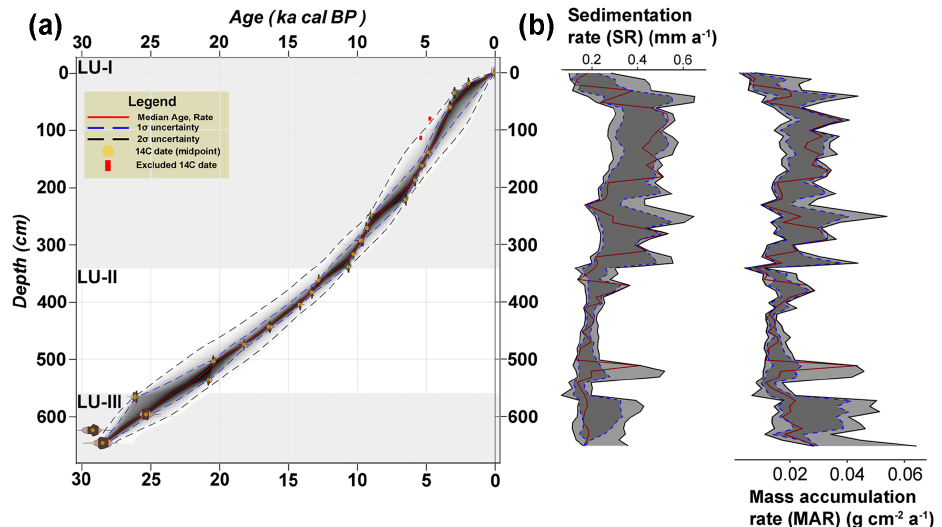
Figure 4. (a) High-resolution age-depth model for sediment core EN18218 created from 23 radiocarbon dates with sigma uncertainty range. (b) Sedimentation and mass accumulation rates (dark red lines) and 1 σ and 2 σ uncertainty ranges (dark and light grey ribbons).